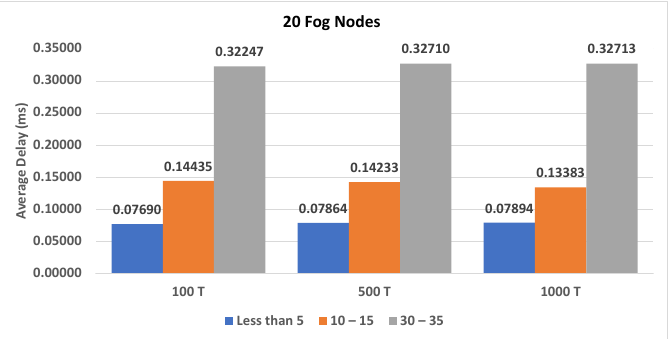
Figure A9. The impact of the different sets of affected transactions on 15 fog nodes.